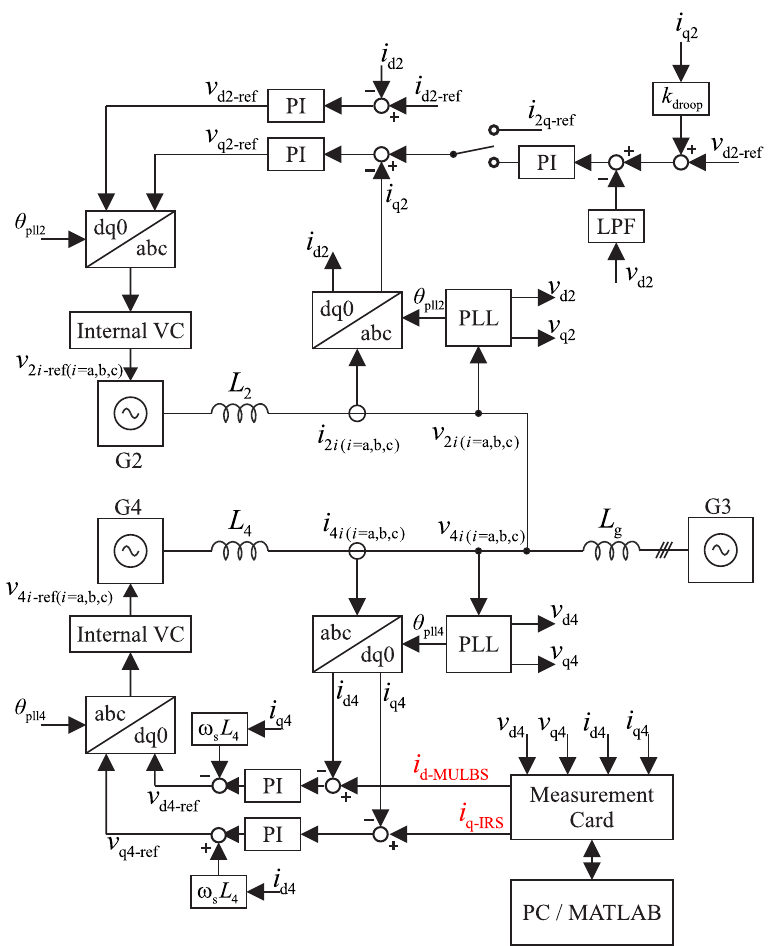
Figure 10. Layout of the measurement setup to study the effect of control functions of a parallel converter.